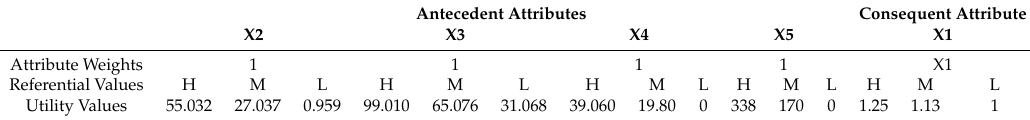
Figure 11. Data vs learning time for the disjunctive BRB. Table 10. Initial structure of the disjunctive BRB for the Antecedent and Consequent part.